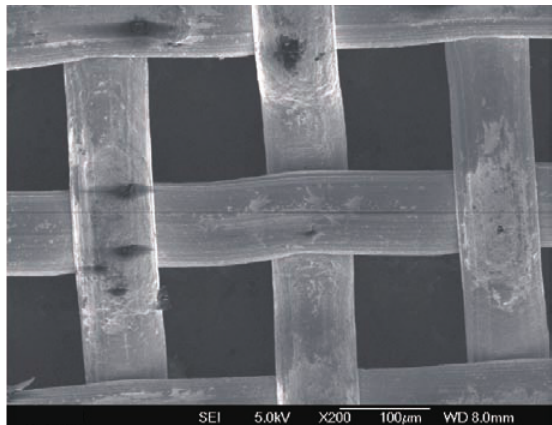
Fig. 2 An SEM image for the stainless steel 304 screen.